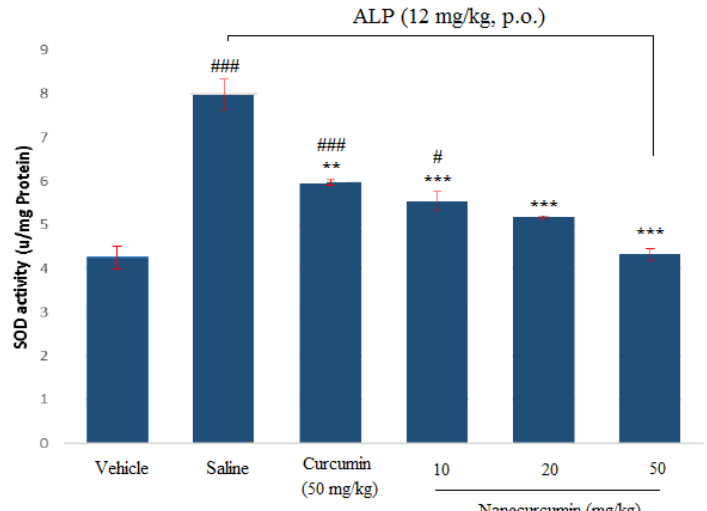
Fig. 3. Effects of curcumin and nanocurcumin on SOD levels in ALP-intoxicated rats. # P<0.05 and ### P<0.001 significantly different from vehicle. ** P<0.01 and *** P<0.001 significantly different from control group (ALP + saline).